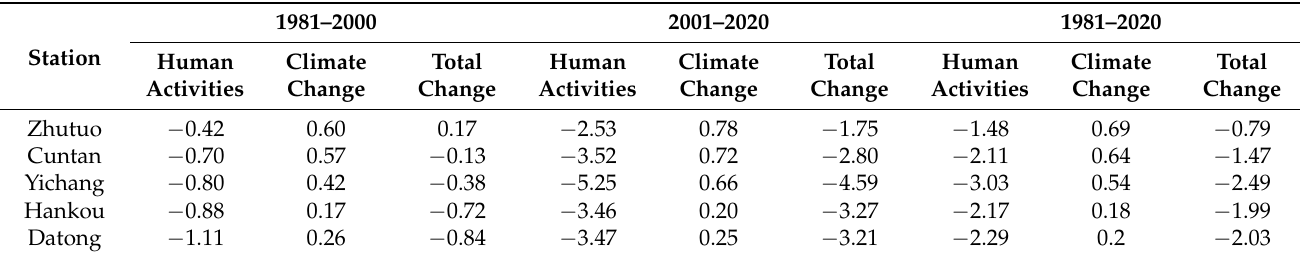
Table 6. Variations of sediment load caused by climate change and human activities, compared with the natural period (1961–1980)